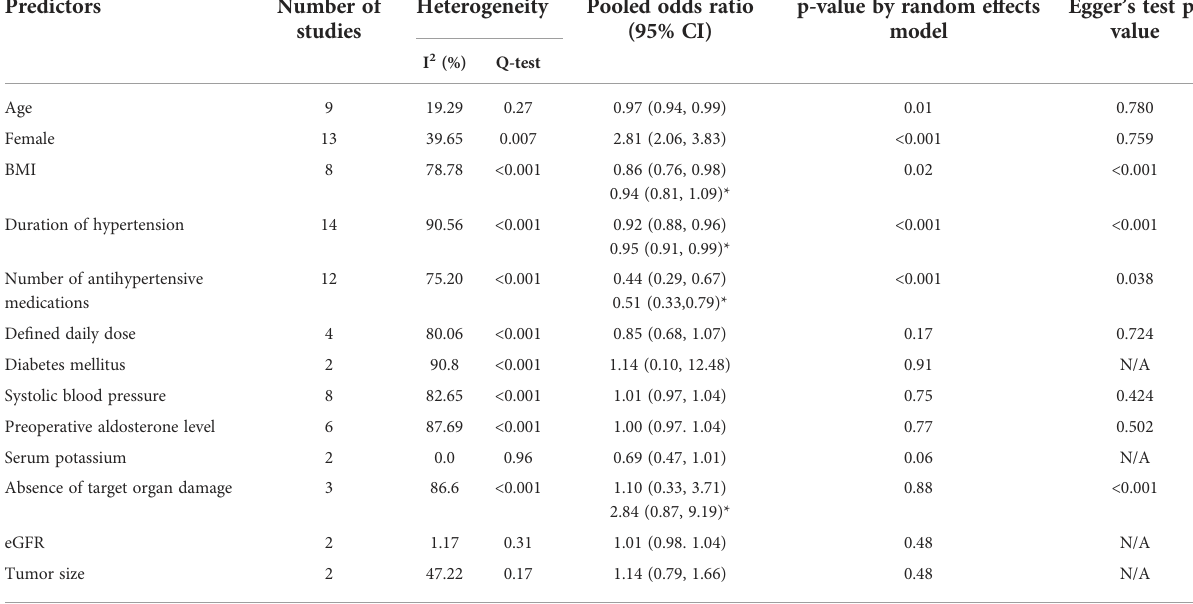
TABLE 2 Meta-analysis of predictive factors of clinical success after adrenalectomy in primary aldosteronism using fully adjusted odds ratio.